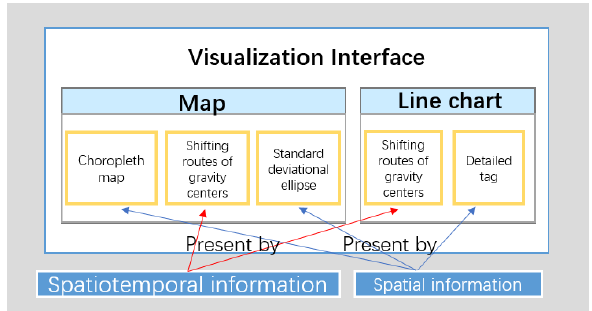
Figure 4. The basic representation form of visualization